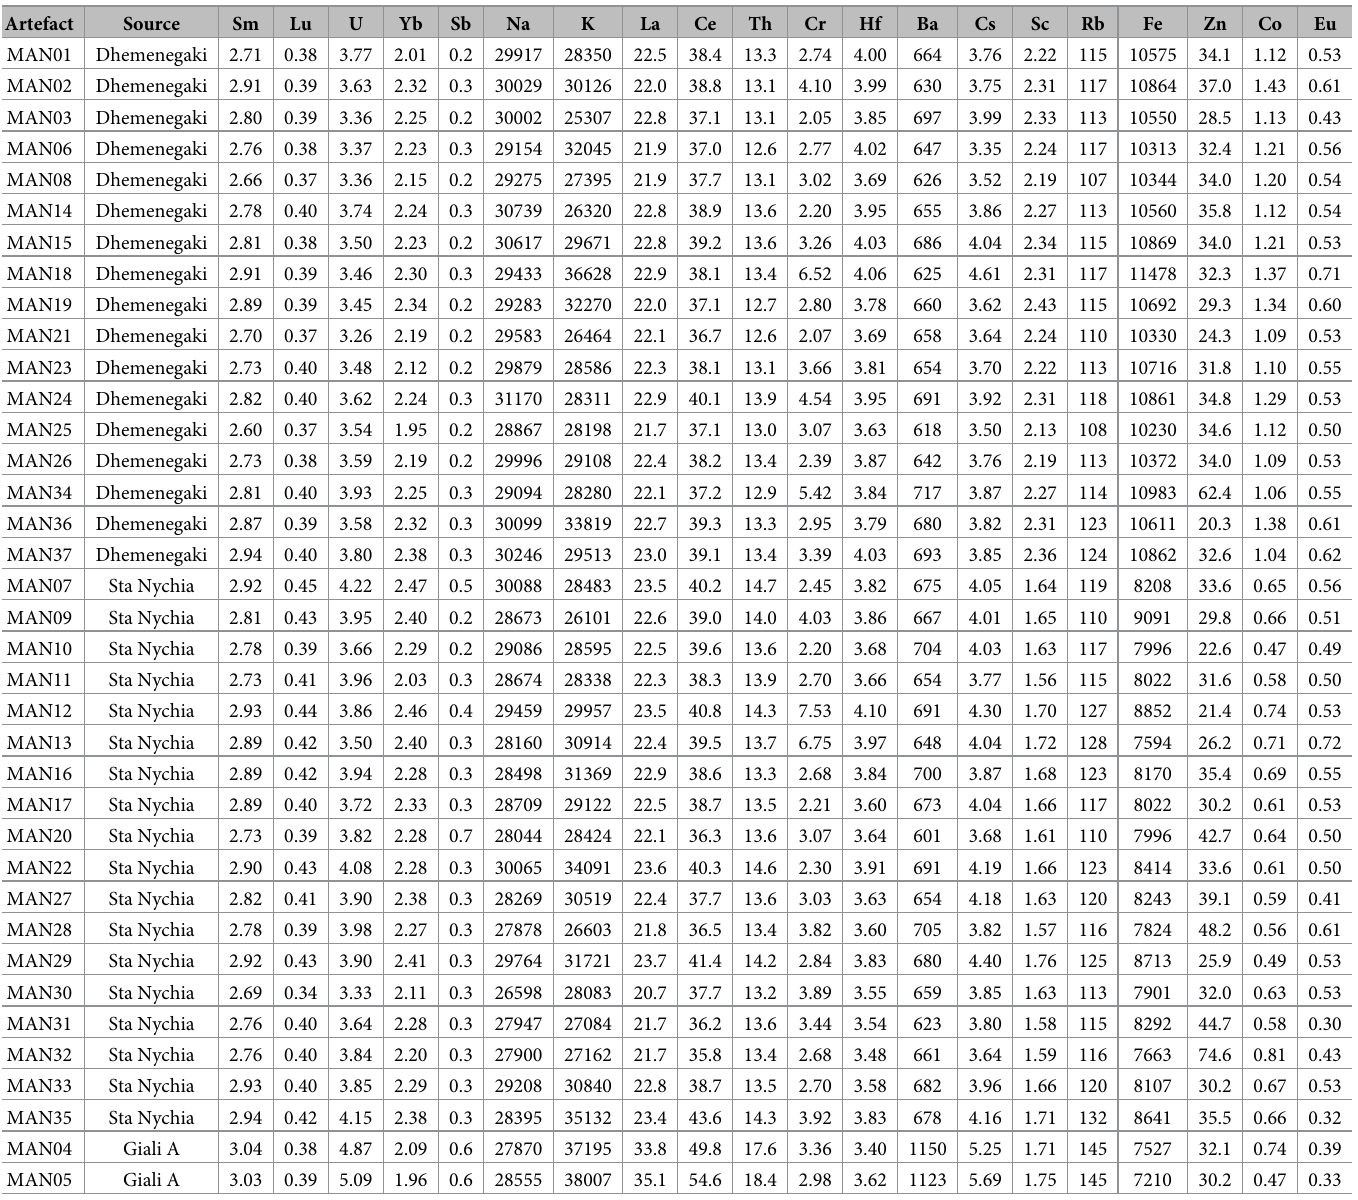
Table 3. Element content and source assignment for the 36 Quartier Nu